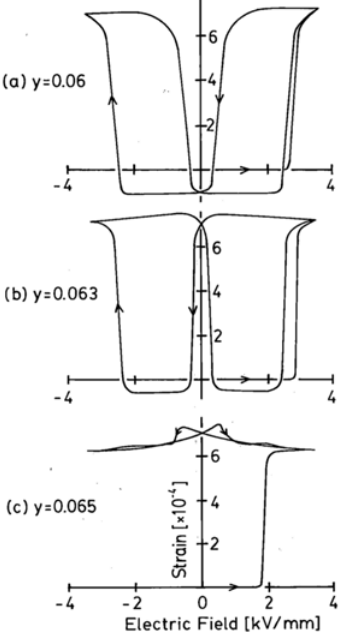
Figure 10. Transverse induced strains in Pb 0.99 Nb 0.02 [(Zr 0.6 Sn 0.4 ) 1-y Ti y ] 0.98 O 3 at room temperature: ( a ) for y = 0.06; ( b ) for y = 0.063; and ( c ) for y = 0.065.